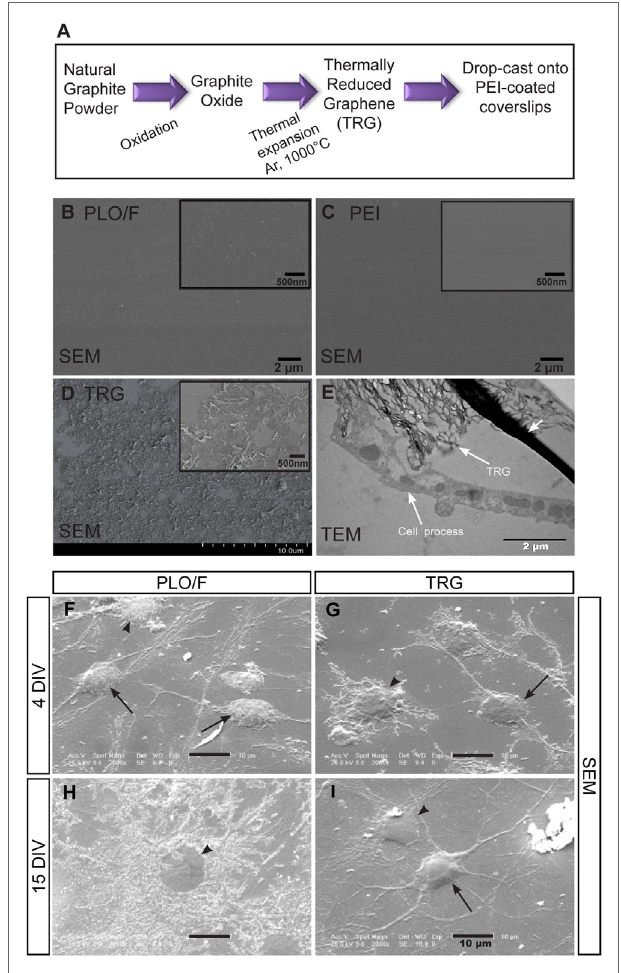
FigUre 1 | The distribution of PlO/F, Pei, and Trg on glass coverslips and the growth of aOBsc-derived neurons and glia on these materials . The scheme summarizes the preparation of TRG and coating of glass coverslips (a) . SEM microphotographs of coverslips coated with PLO/F and PEI are shown prior to seeding (B,c) . SEM microphotograph of the TRG coating reveals the wrinkle structures of TRG and that the material is relatively uniformly distributed and is almost completely covering the coverslip, prior to cell seeding (D) . The insets in (B–D) show high magnification images. The TEM photograph (e) shows the close contact between the cell processes and the TRG (indicated by arrows). The small arrow points to artifacts due to the technique used. The SEM microphotographs show various healthy, differentiated cells on PLO/F-coated coverslips (F,h) and TRG-covered coverslips (g,i) after 4 DIV and 15 DIV. For images (F–i) , arrows indicate cells having neuronal morphology whereas the arrowheads point to glial